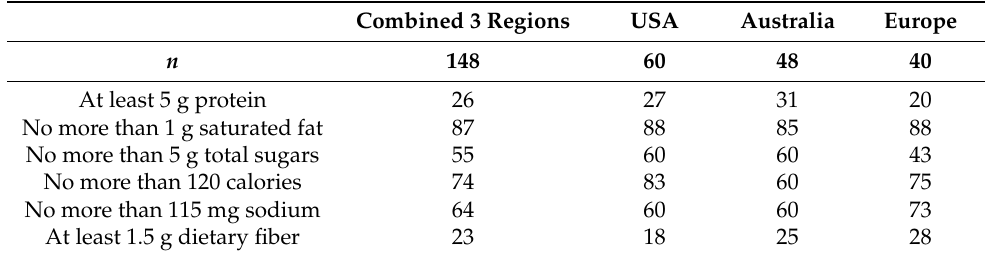
Table 4. Percentage of non-dairy beverages meeting the suggested nutrient guideline per serving, by region.